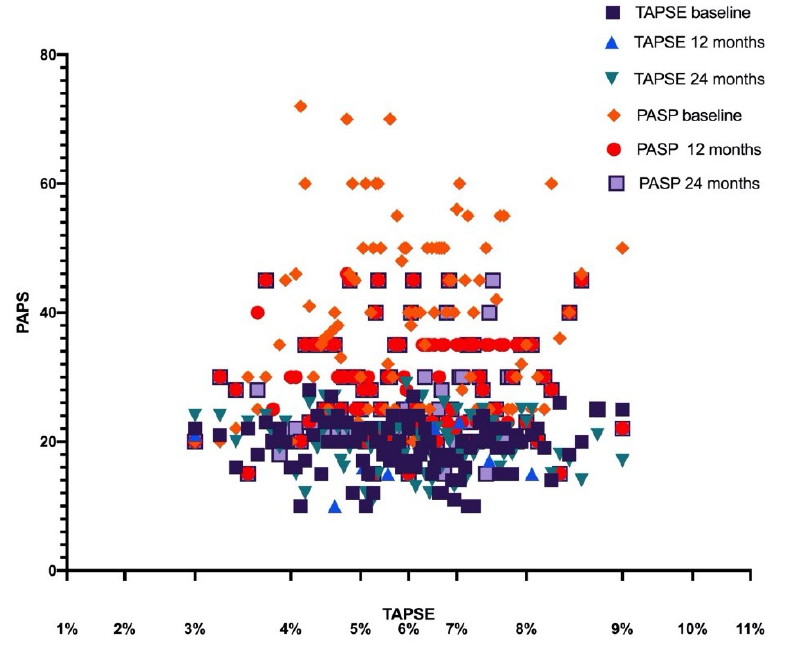
Figure 2. Improvement in the right ventricular arterial coupling during follow-up. TAPSE—tricuspid annular plane systolic excursion; PASP—pulmonary artery systolic pressure; ns—not significant. J. Clin. Med. 2020 , 9 , x FOR PEER REVIEW